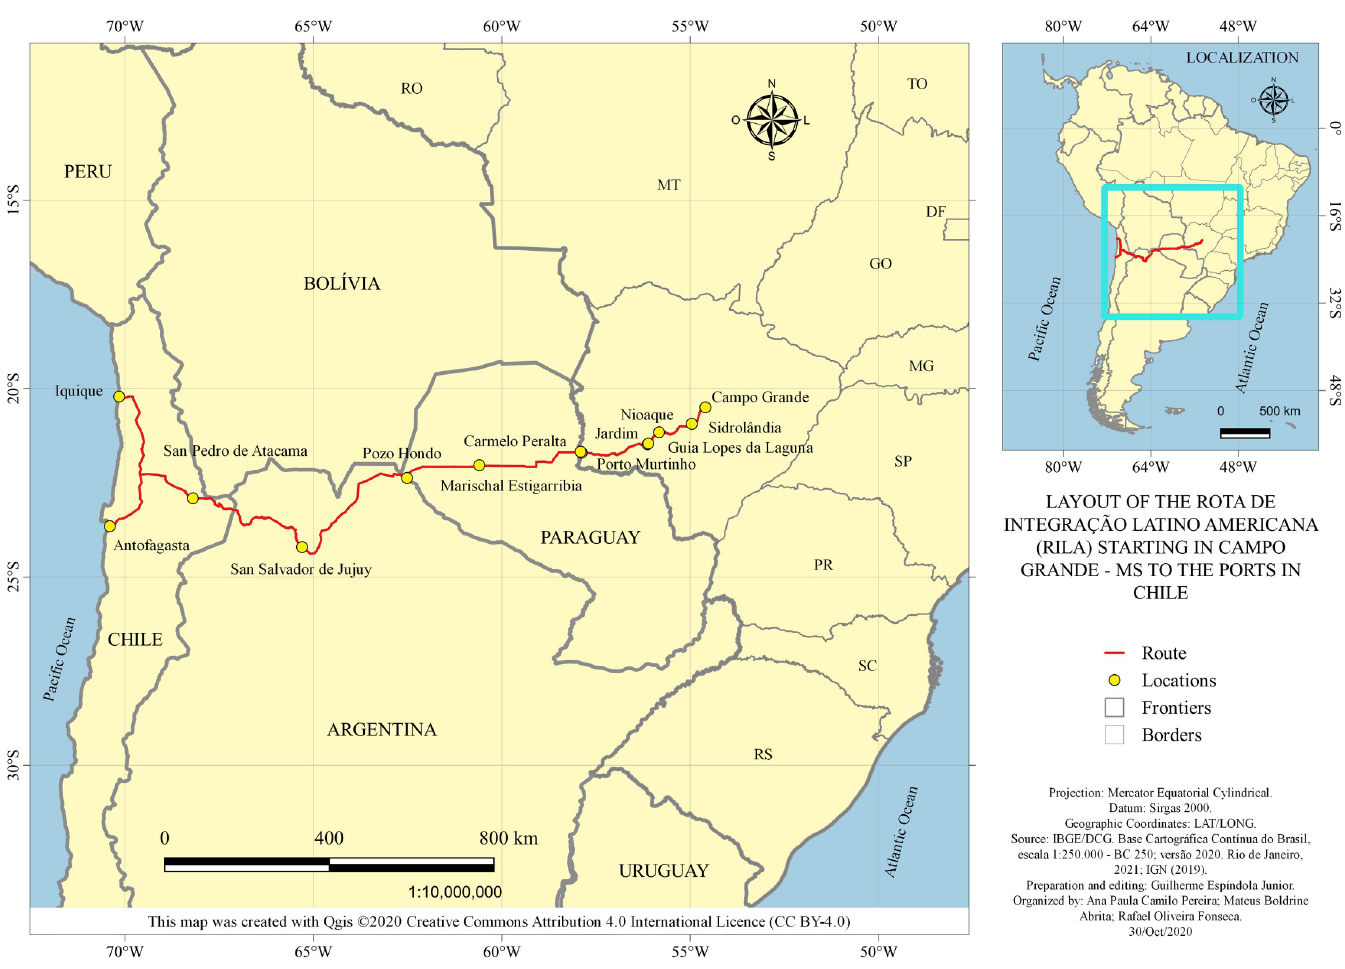
Fig 3. The layout of the Rota de Integração Latino Americana (RILA) starting in Campo Grande—MS to the ports in Chile. Caption credit: Elaborated from [15].